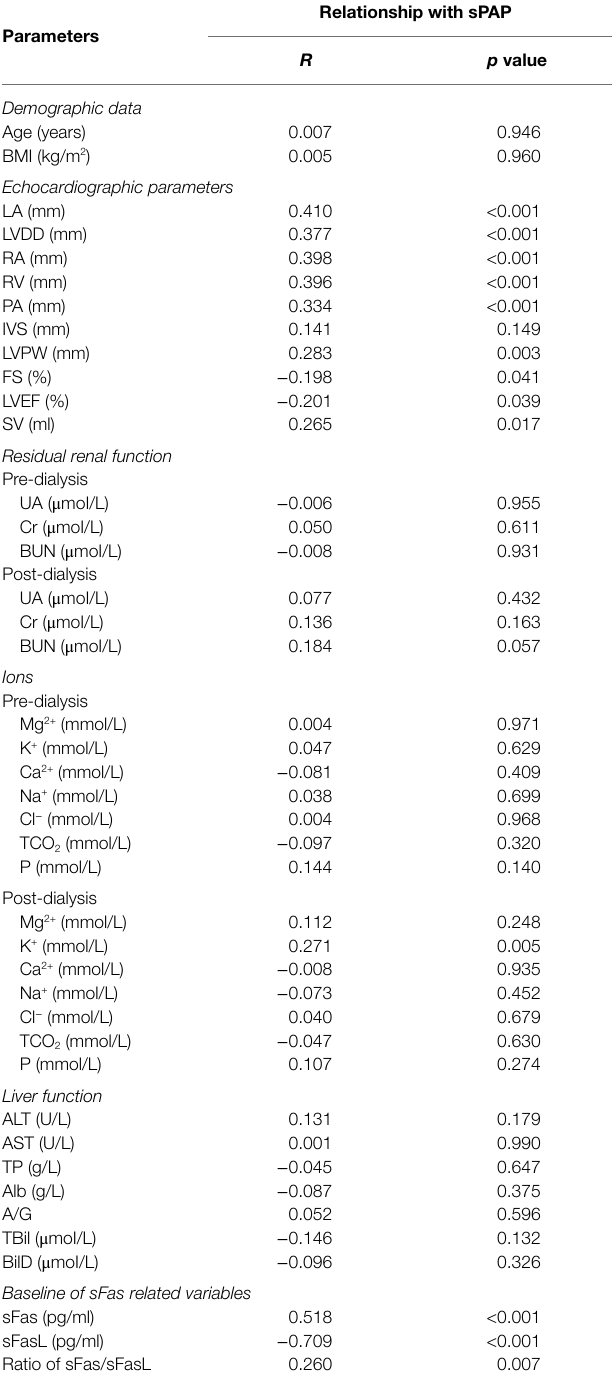
Relationship with